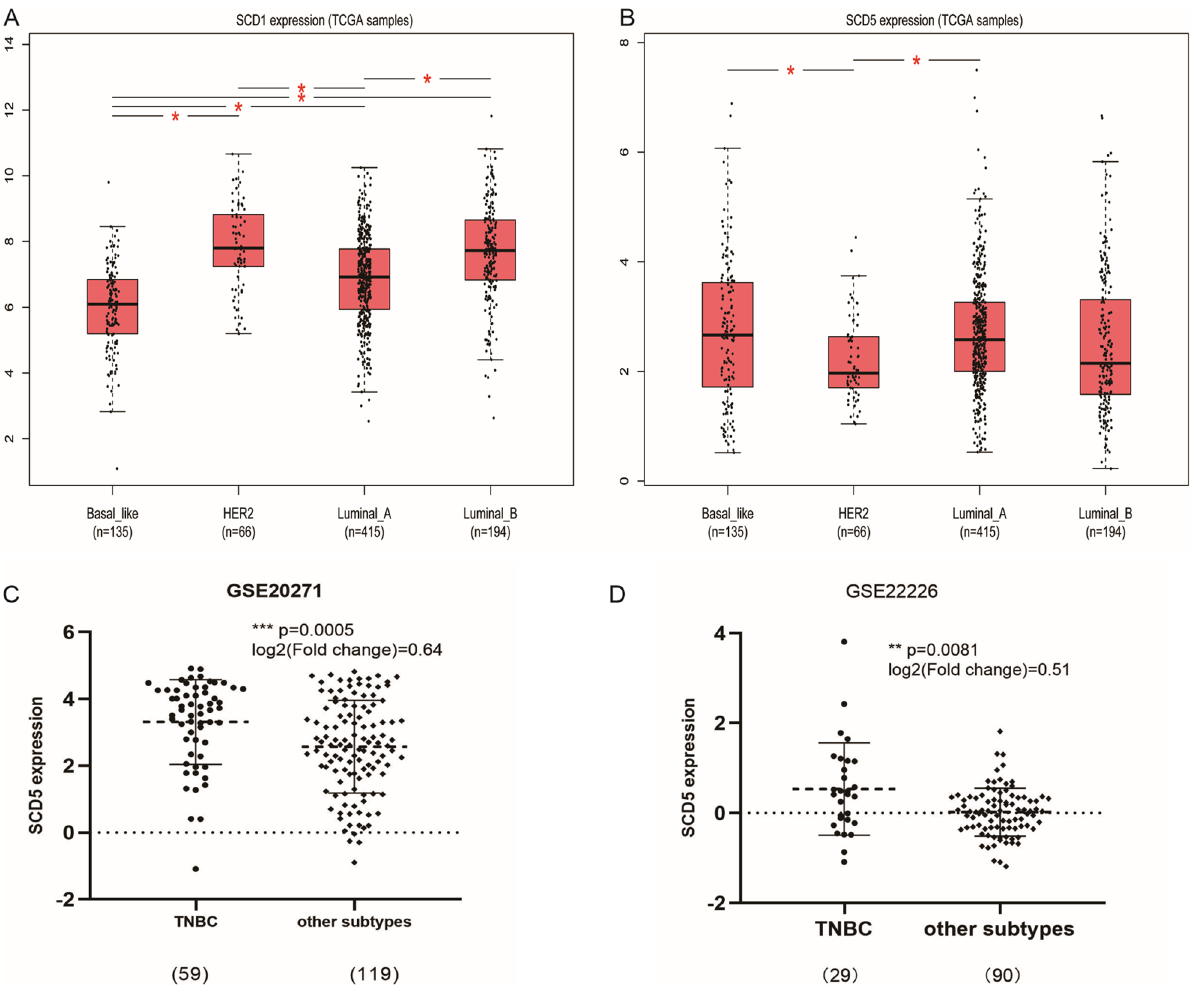
Figure 3. The correlation between SCDs (SCD1 and SCD5) mRNA expression and breast cancer molecular subtypes. ( A , B ) SCD1 and SCD5 mRNA expression in different molecular subtypes of breast cancer by using TCGA samples. ( C , D ) SCD5 mRNA expression in different molecular subtypes of breast cancer by using GEO